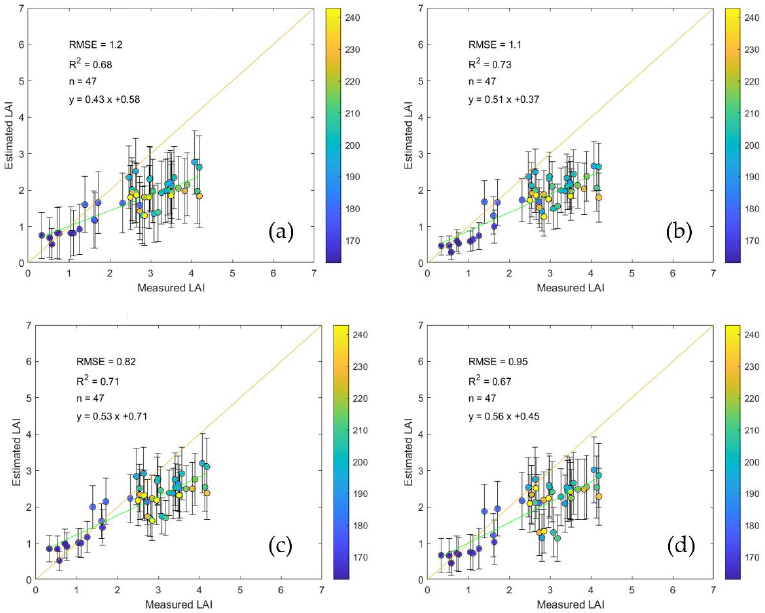
Figure 7. Comparison of estimated and measured LAI using reflectance-based look-up-table (LUT) for Landsat 7 / 8. The spectral bands used for inversion correspond to ( a ) R; ( b ) R and NIR; ( c ) R, NIR, SWIR1 and SWIR2; ( d ) SWIR1 and SWIR2. Error bar represents the standard deviation of LAI retrievals. Color bar represents DOY (i.e., day of year) of images.